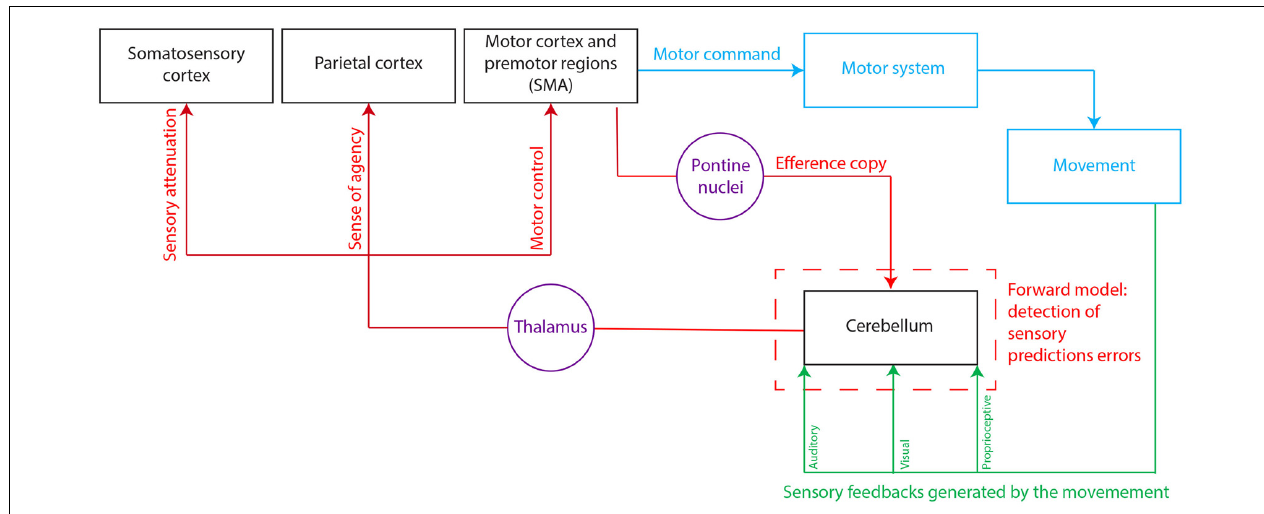
FIGURE 1 | Hypothetical model for the cerebro-cerebellar loops involved in the forward model. The cerebellum is thought to integrate the efference copy—a copy of the motor command that originates from the motor and premotor areas and represents the intentional content of the action—and the actual sensory feedback generated by the movement. The existence of a discrepancy between the predicted and actual motor outcome (or sensory prediction error) would be detected at the level of the cerebellum. This signal error would then be sent to different cortical areas to serve different functions: motor control, sensory attenuation, and sense of agency. SMA, supplementary motor